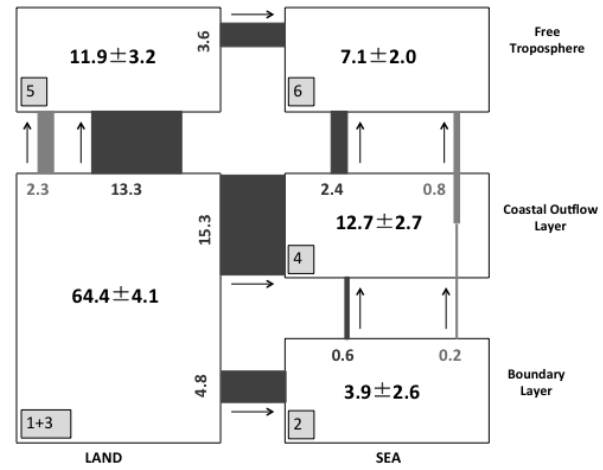
Fig. 7. 24 h running average timeseries of net tracer fluxes from the